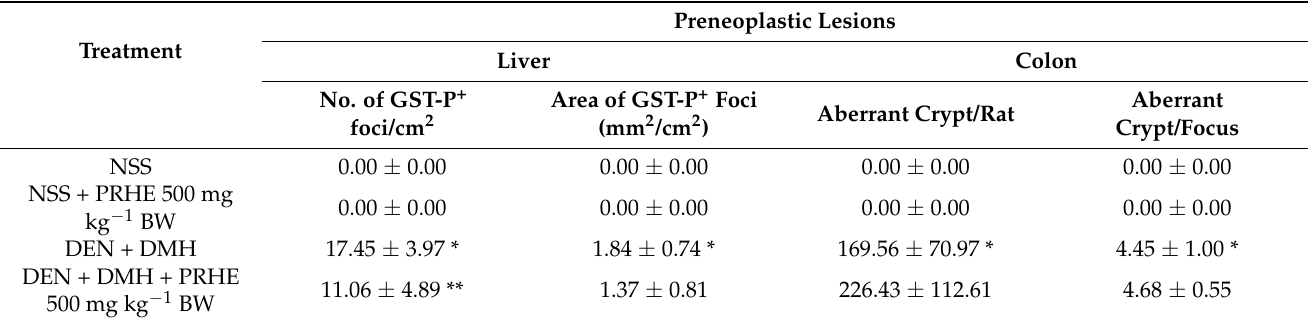
Table 2. The number of hepatic GST-P-positive foci and colonic ACF of rats initiated with diethylnitrosamine and 1,2- dimethylhydrazine.